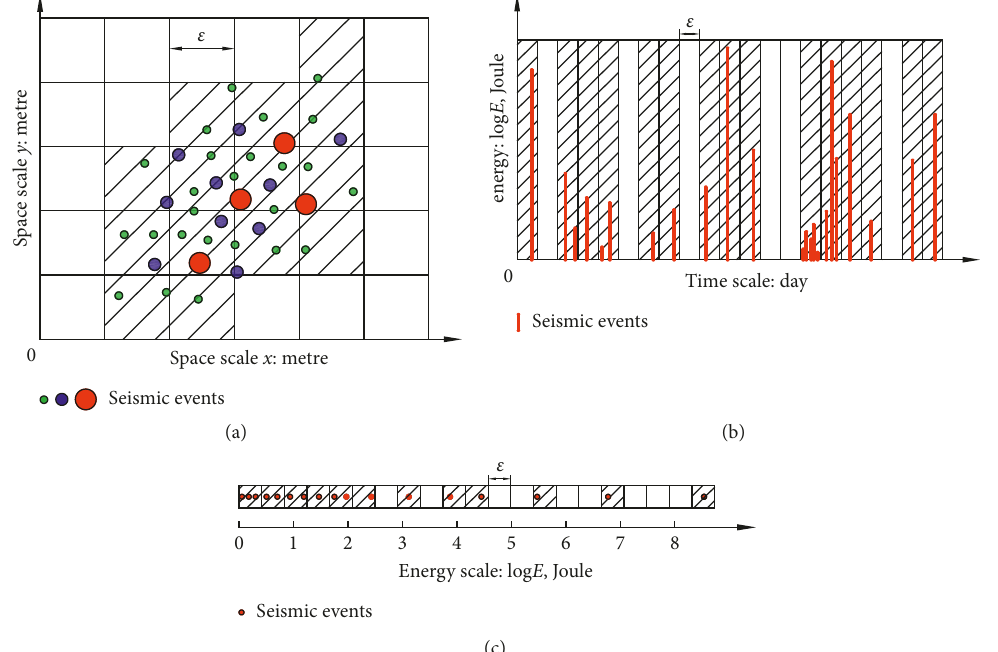
Figure 1: Box-counting method for estimating fractal dimension in the (a) space scale, (b) time scale, and (c) energy scale of AE events. Filled circles indicate AE events and different colours denote different